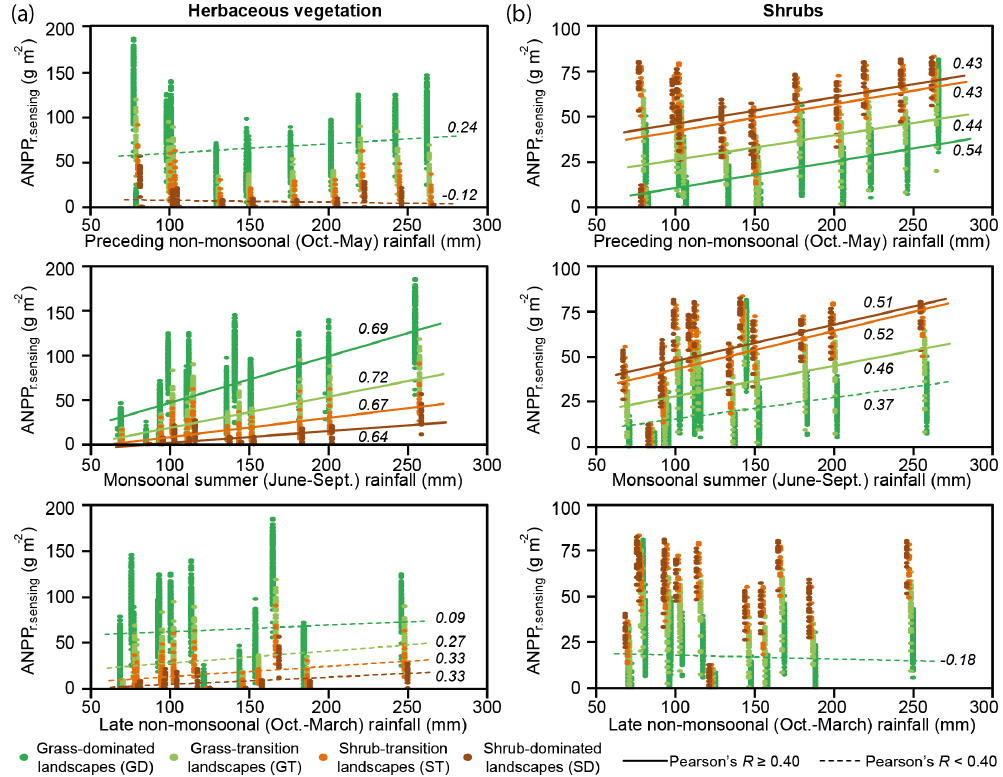
Figure 7. Scatter plots and correlations (Pearson’s R ) between remotely sensed ANPP estimations and seasonal precipitation (preceding non-monsoonal, summer monsoonal, and late non-monsoonal rainfall) for the different landscape types (grass-dominated, grass-transition, shrub-transition, and shrub-dominated landscapes): (a) herbaceous ANPP and (b) shrub ANPP. Solid and dotted lines represent strong ( R ≥ 0 . 40) and weak ( R < 0 . 40) correlations, respectively. Displayed correlations are significant at P < 0 . 05. Numbers within the plots indicate correlation